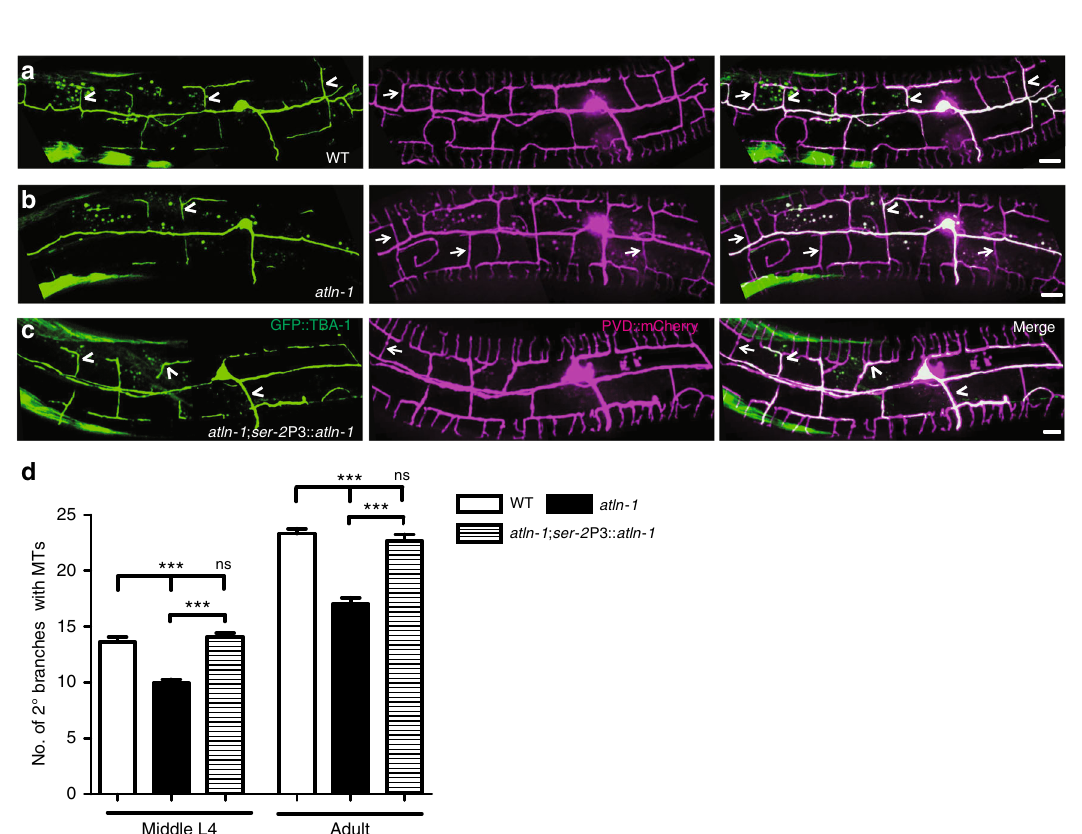
Fig. 3 a tln-1 mutants show high level of ER retraction. a – c Kymographs of ER (GFP::SP12) dynamic events in PVD 3° branches in WT ( a ), atln-1 ( b ), and atln- 1; ser-2 P3:: atln-1 ( c ) worms at L4 stage. Magenta, white and yellow arrows indicate ER growth, retraction, and static events, respectively. Scale bar, 5 μ m and 10 s. d Quanti fi cation of ER growth and retraction frequency. Values are mean and error bars are SEM. At least 200 events from more than 30 worms are quanti fi ed. ns, not signi fi cant, ** p < 0.01 (Newman-Keuls multiple comparison test). e, f Quanti fi cation of ER growth ( e ) and retraction ( f ) length. Values are mean and error bars are SEM. At least 200 events from more than 30 worms are quanti fi ed. ns, not signi fi cant; *** p < 0.001 (Newman-Keuls multiple comparison test). g – i Representative 3D-SIM images of ER (GFP::SP12) complex structure at the most proximal branch point of the PVD anterior dendrite in WT ( g ), atln-1 ( h ), and atln-1; ser-2 P3:: atln-1 ( i ) worms. j Quanti fi cation of ER complexity index of the most proximal branching point. Values are mean and error bars are SEM, n > 40. ** p < 0.01; *** p < 0.001 (Newman-Keuls multiple comparison test). To calculate the complexity index, we drew a circle of 1.6 μ m diameter (dashed circle) at the branching point and a line within the circle along the dendrite trunk (dashed line). Complexity index = mean GFP intensity in the circle/mean GFP intensity on the line. Scale bars, 1 μ m. k Quanti fi cation of ER complexity index at posterior branch points. Values are mean and error bars are SEM. At least 100 branch points from more than 30 worms are quanti fi ed. * p < 0.05; *** p < 0.001 (Newman-Keuls multiple comparison test). l Scanning electron microscopy images from a serial EM pictures showing ER complex structure on a branch point in PVD of a WT worm. The magenta arrows indicate ER. The blue arrows indicate PVD 2° branches. Scale bar, 500 nm